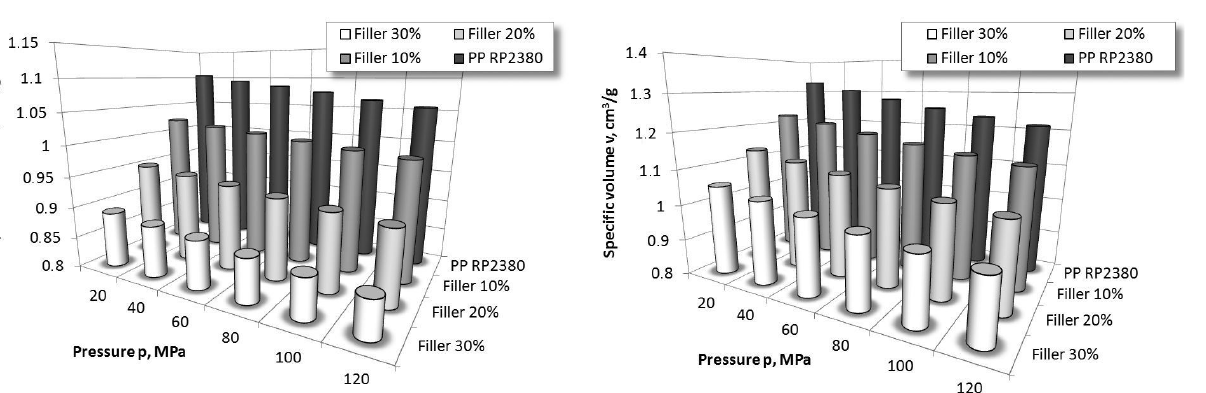
Figure 6: Changes of specific volume depending on the pressure and the filler content at processing temperature (240 ∘